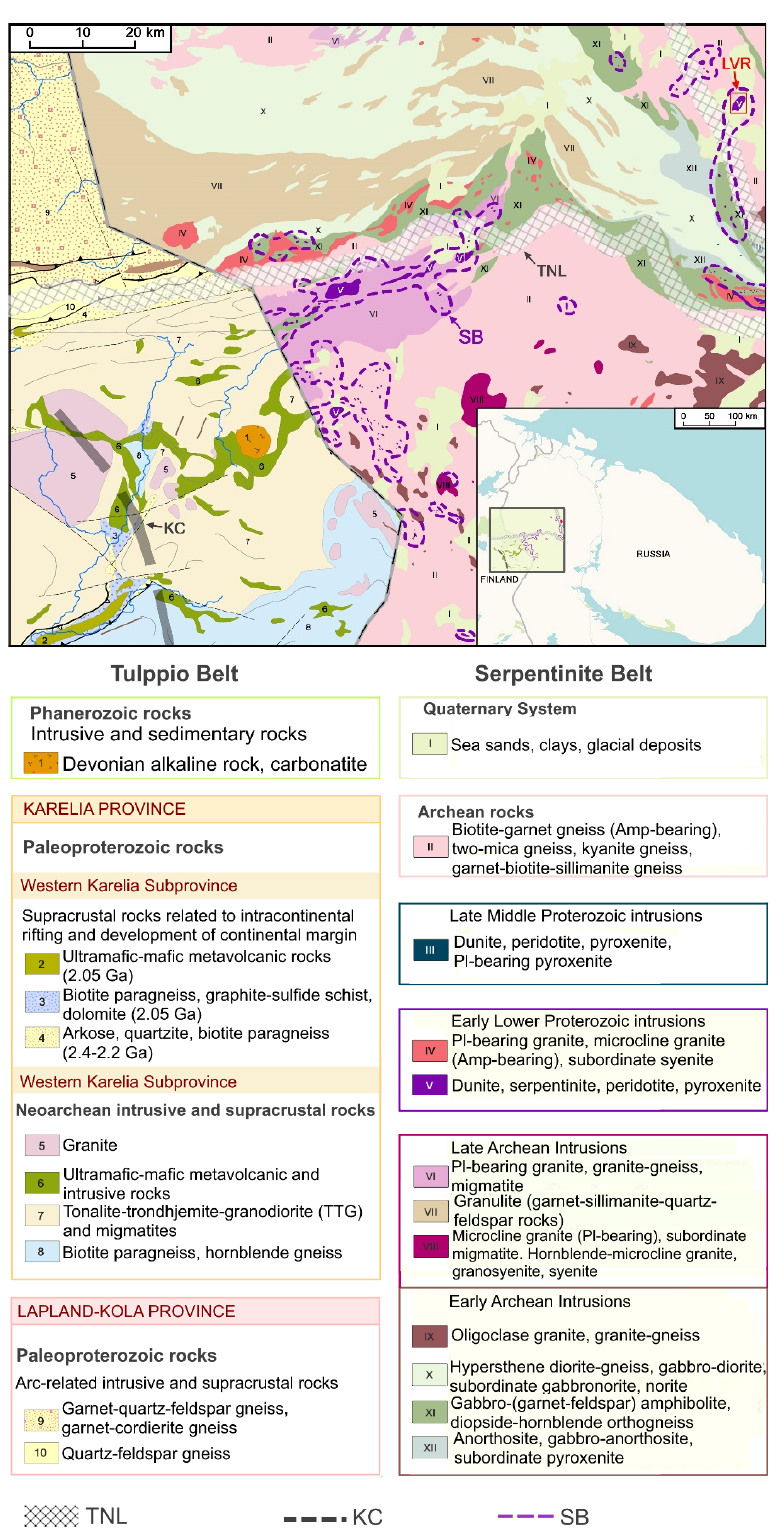
Figure 3. Location of the Lyavaraka and Pados-Tundra complexes, shown in the context of tecton- ic elements of the northeastern part of the Fennoscandian Shield, after [28] and references therein.